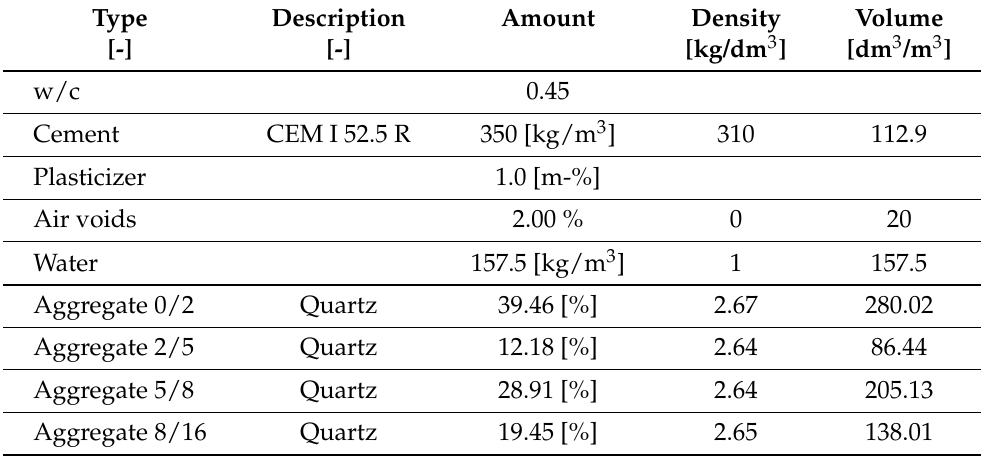
Table 1. Composition of concrete standard AB16 used in the